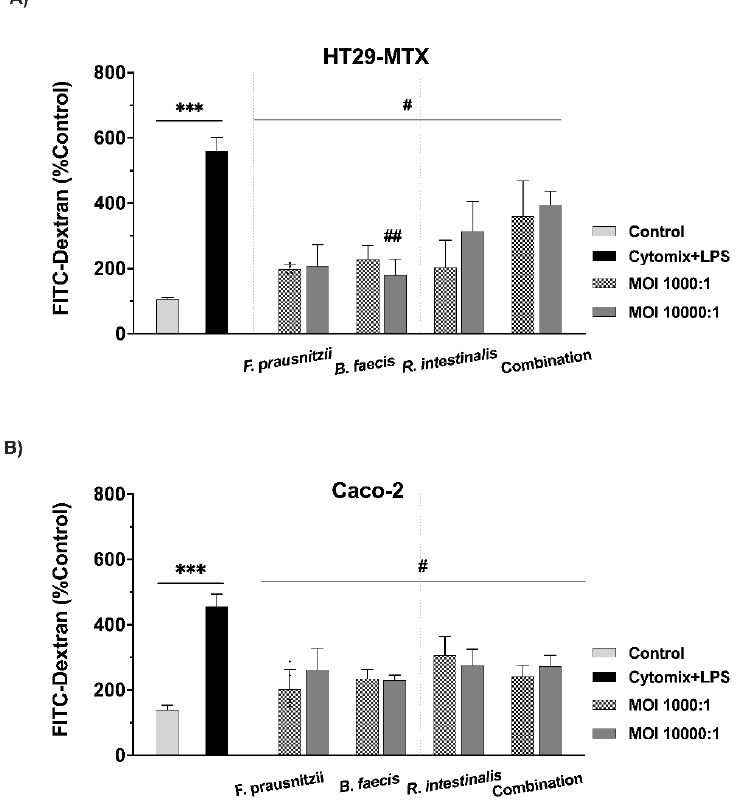
Figure 3. Paracellular permeability was determined by the flux of FITC–dextran through the differentiated HT29-MTX ( A ) and Caco-2 ( B ) monolayers. Cell monolayers were incubated with cytomix + LPS. After 6 h incubation with bacteria individually and in combination, the flux of 4-KDa FITC–dextran was measured. The control group received culture media. Data are presented as the means ± SD (n = 4). *** p ≤ 0.001 cytokine compared to control and # p ≤ 0.05, ## p ≤ 0.01 treated groups compared to cytokine, as determined by the Mann–Whitney U test.